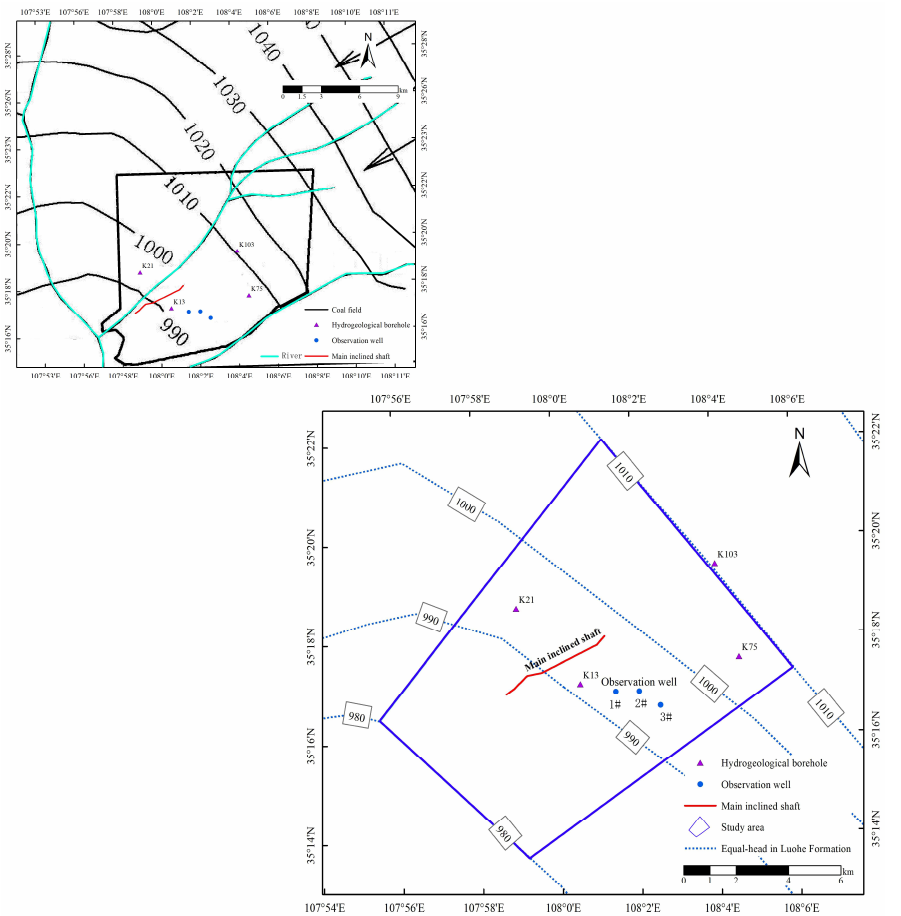
Figure 2. The schematic diagram of the study area and the isolevel map of the Luohe Formation aquifer.